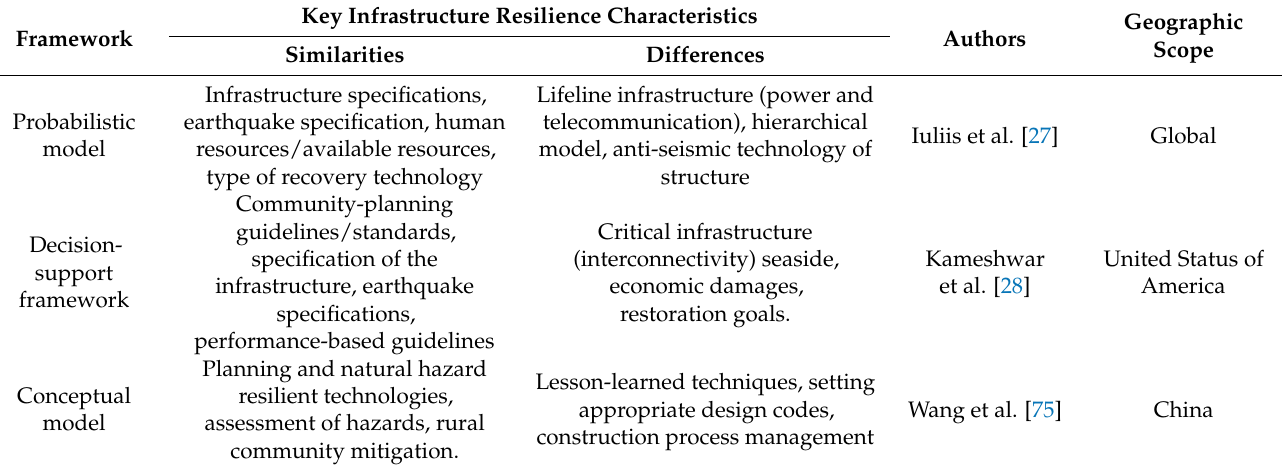
Table 2. Example of key infrastructure resilience characteristics developed for specific geographic scope.